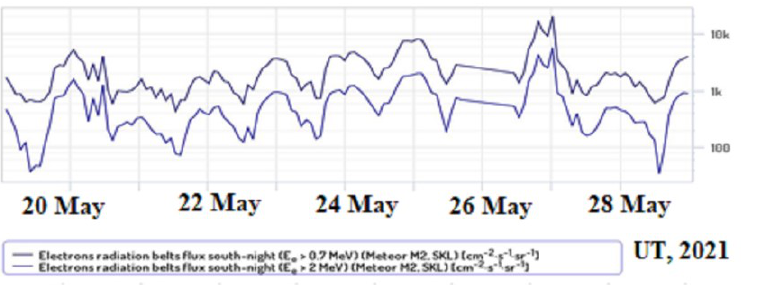
Fig. 3. Time profiles of electron fluxes at ERB maximum obtained from polar orbit data 19-